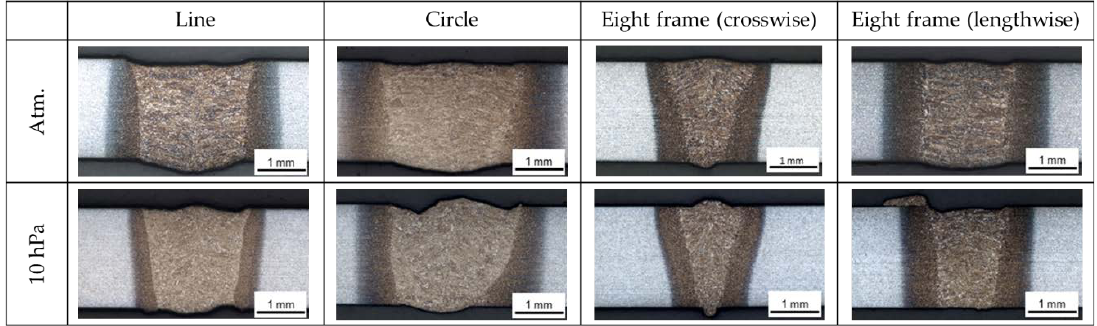
Figure 7. Resulting weld seam geometry using different laser oscillation patterns at atmospheric pressure and 10 hPa.